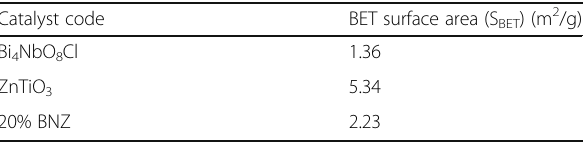
Table 1 Specific BET surface areas parameters of the Bi 4 NbO 8 Cl, ZnTiO 3 , and 20% BNZ samples Catalyst code